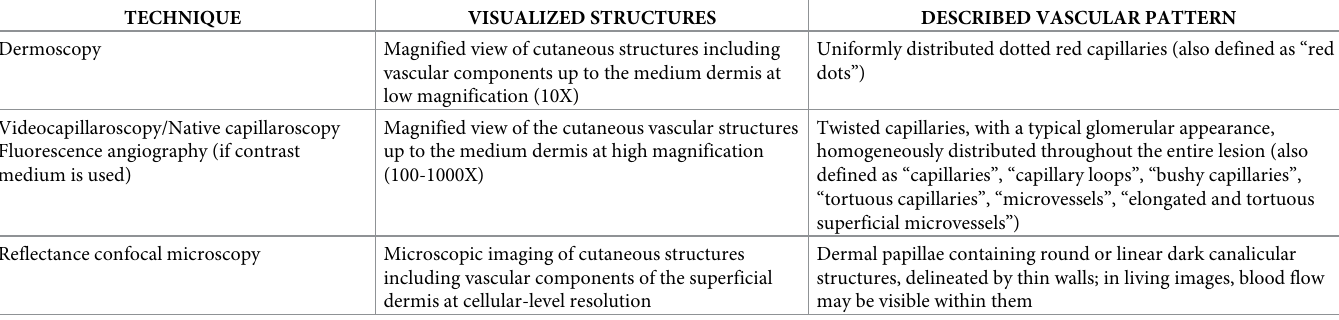
Table 1. Main techniques for the evaluation of microcirculation in psoriasis.